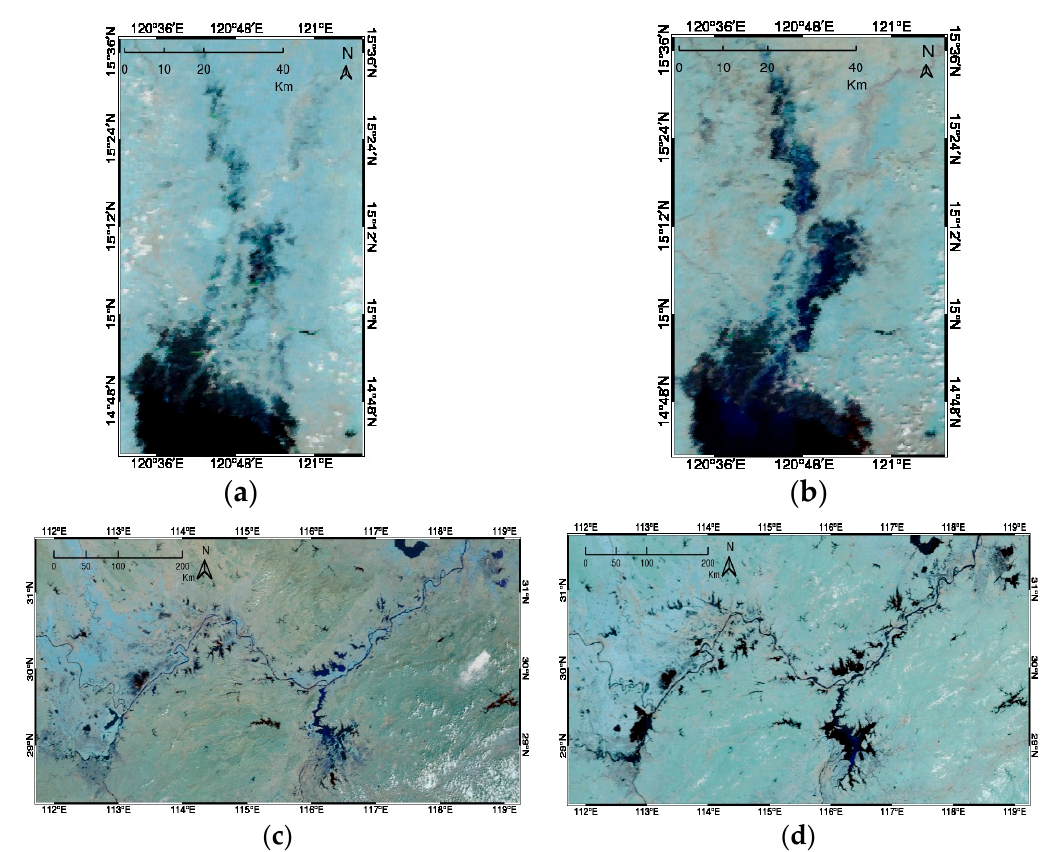
Figure 6. Surface reflectance histograms for MODIS bands ( a ) 1 to ( g ) 7 on 25 October 2015 around the Pampanga River basin, Philippines. Clear bimodal distributions appear in the histograms for bands 2, 5, and 6.